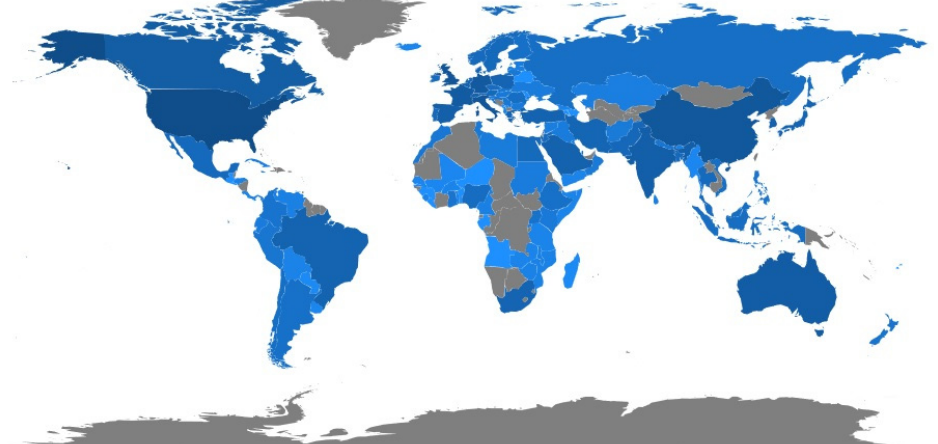
Figure 7. The Geographical map of countries prolific in COVID-19 vaccine research (Dark blue color: countries with a high number of articles related to the COVID-19 vaccine, light blue color: countries with a low number of articles related to the COVID-19 vaccine, gray color: countries without articles related to the COVID-19 vaccine). Table 3. The most prolific countries in COVID-19 vaccine